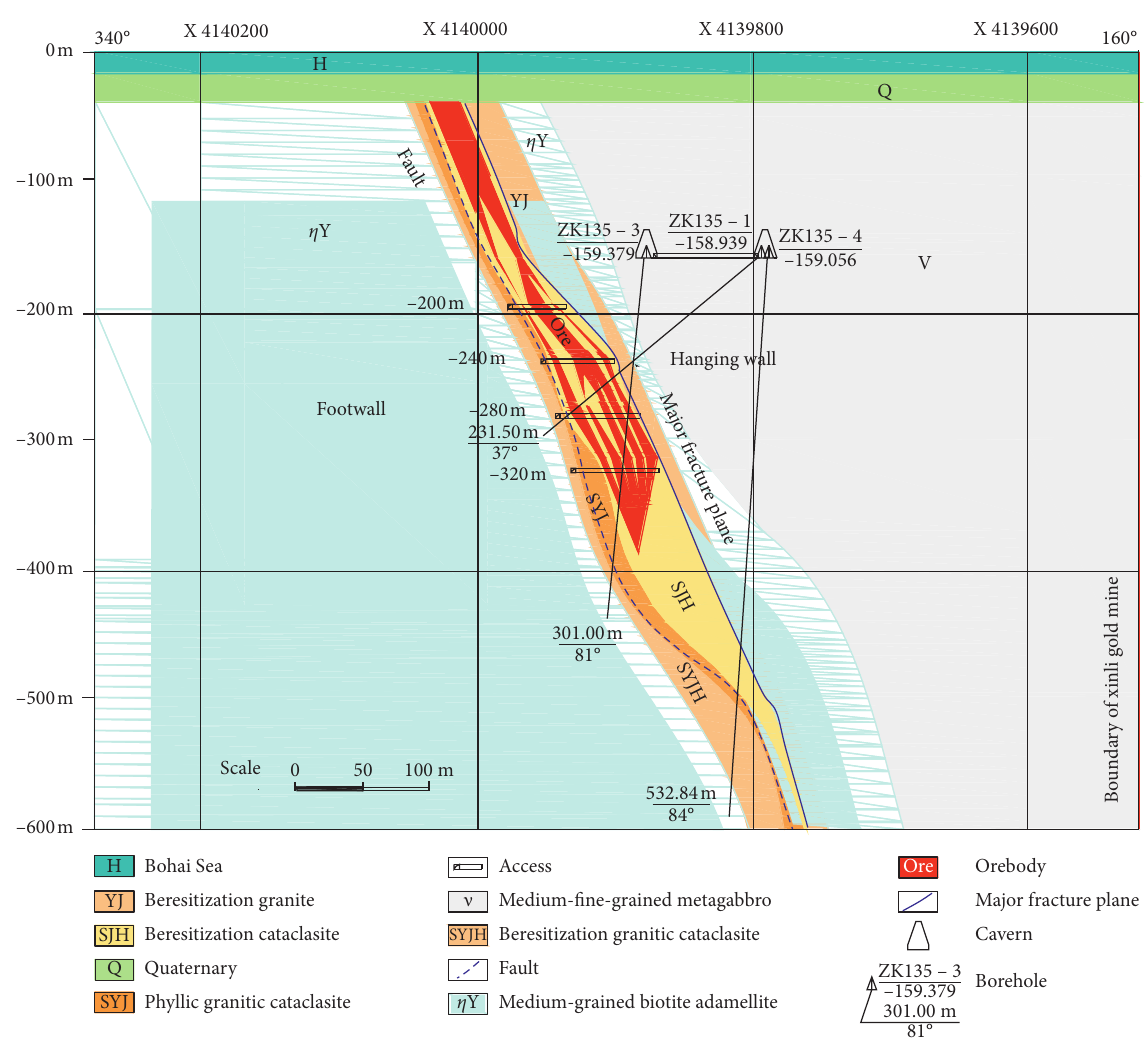
Figure 1: Profile map showing the geological structure of orebody at #135 exploration